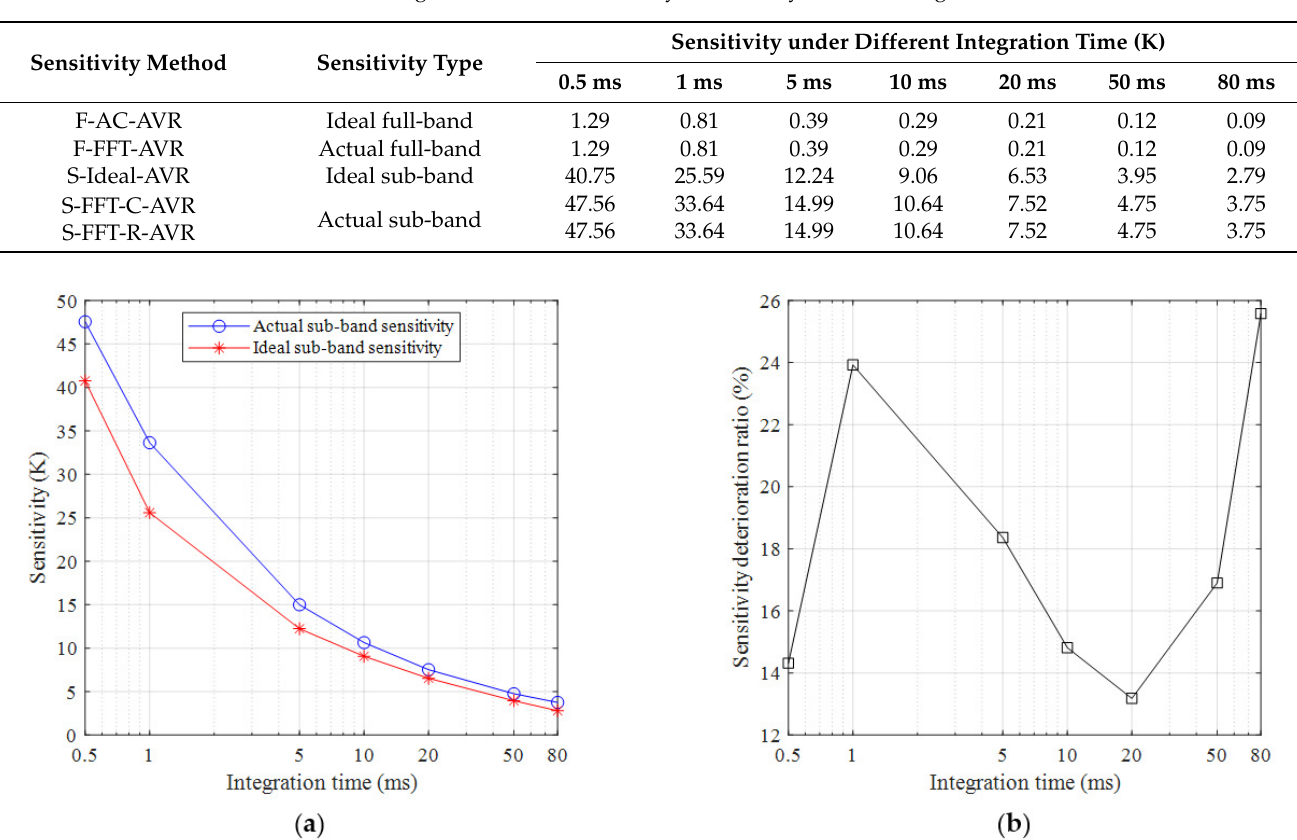
Table 5. The average values of the sensitivity obtained by different integration time.